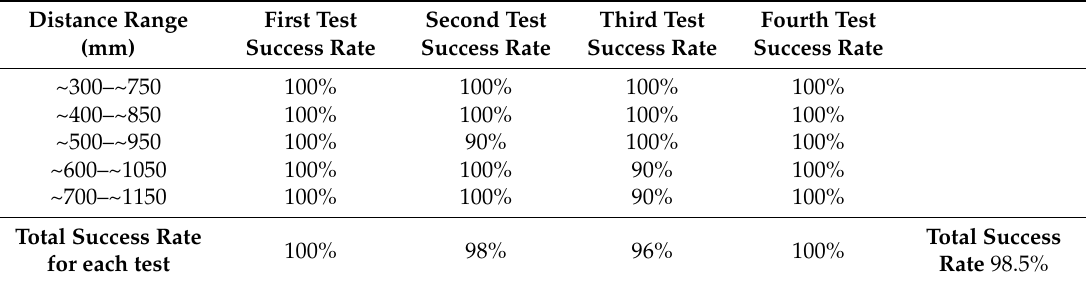
Table 2. Results of the depth estimation tests.